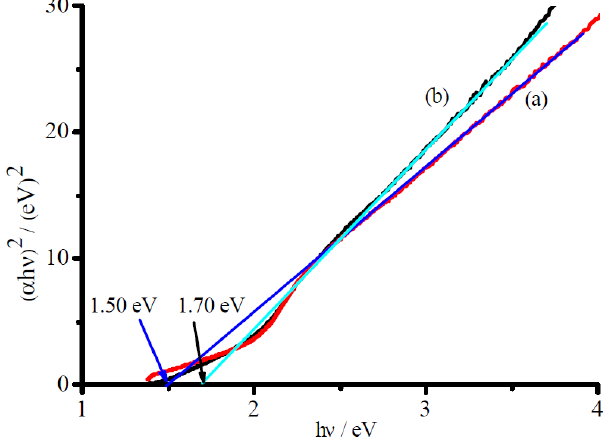
Figure 4. UV–visible near-infrared diffuse reflectance spectra of CuFe 2 O 4 /NG ( a ), CuFe 2 O 4 ( b ) catalysts.